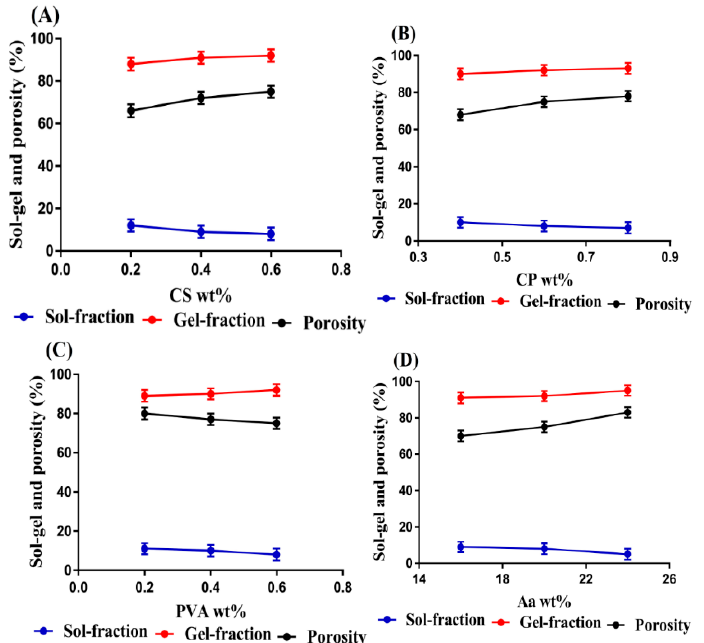
Figure 8. Effect of ( A ) CS, ( B ) CP, ( C ) PVA, and ( D ) Aa on sol–gel fraction and porosity of CS/CP/PVAcPAa hydrogel.